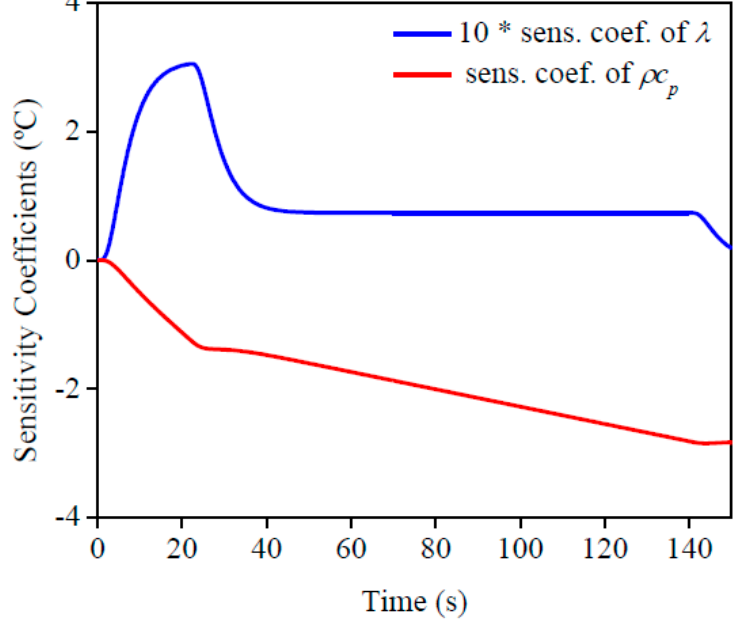
Figure 10. Sensitivity coe ffi cient of the AISI 304 stainless steel sample.